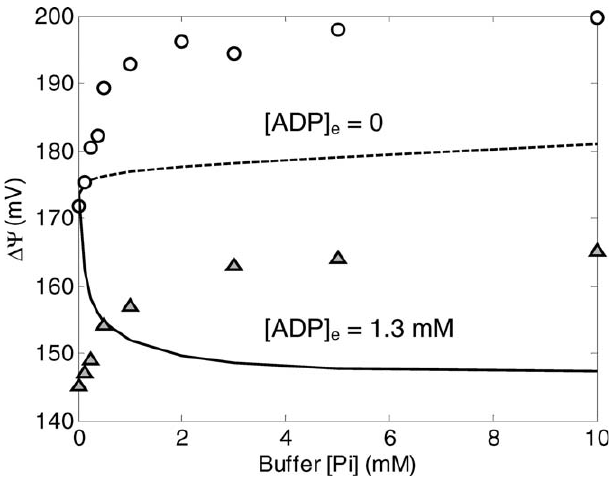
Figure 3. Comparison of Model Simulations to Experimental Data on Membrane Potential for Model without Phosphate Control The model without phosphate control is not able to fit the experimental data on mitochondrial membrane potential. Computed results in this figure correspond to steady-state simulations of the model described under ‘‘ Mitochondrial Model without Phosphate Control. ’’ Model simulations for [ADP] e ¼ 1.3 mM, and [ADP] e ¼ 0 mM are plotted as solid lines and dashed lines, respectively. Experimental data (circles and triangles) are obtained from [10]. DOI: